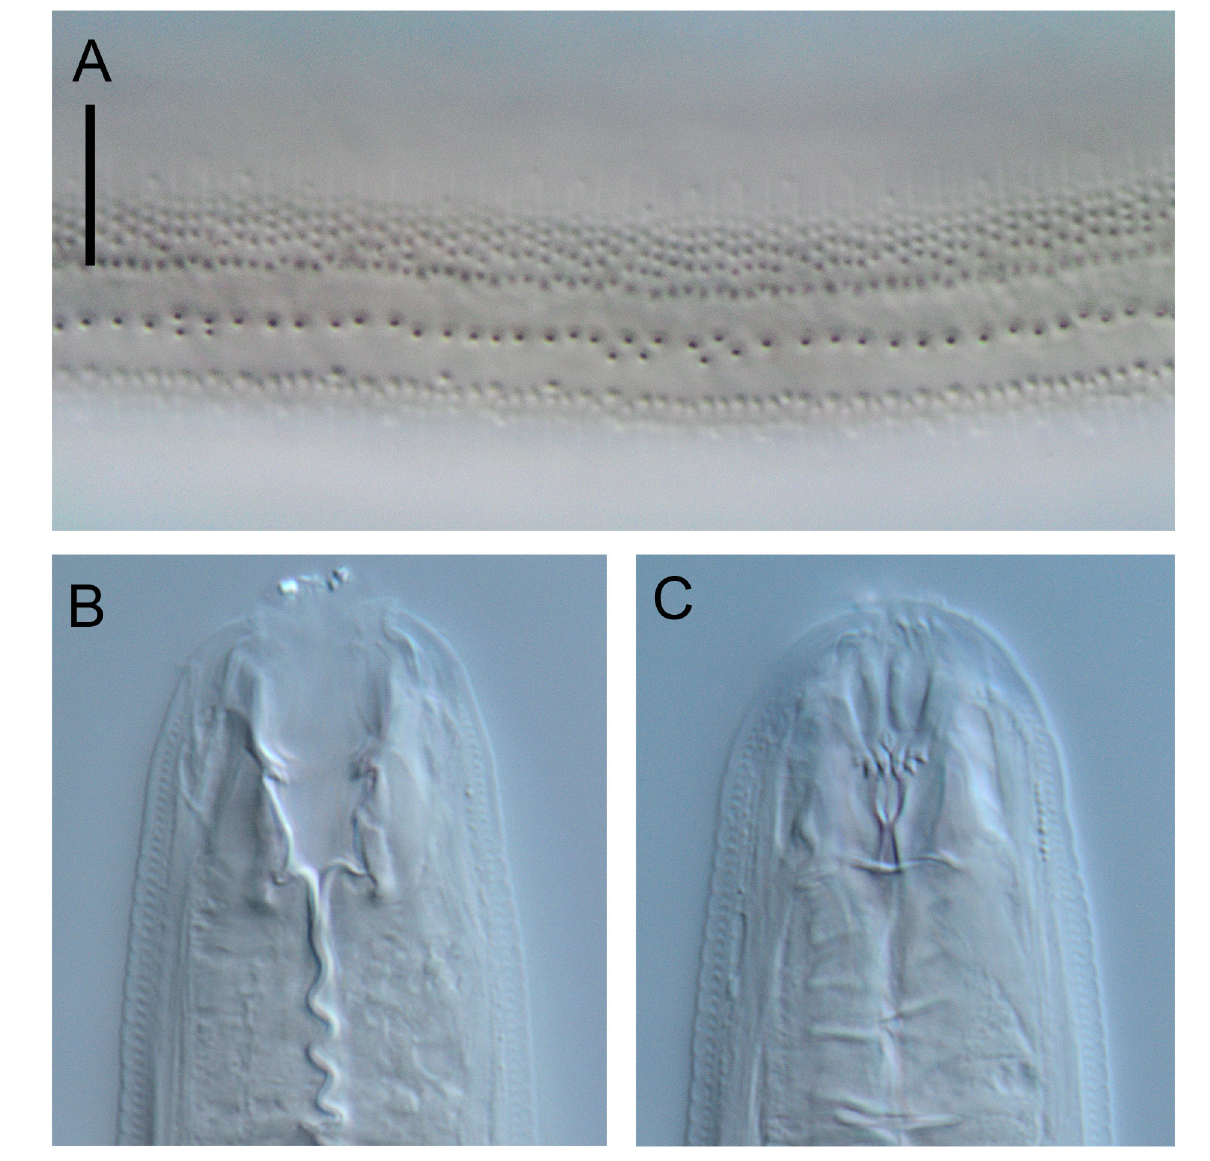
Fig. 16. Bendiella thalassa gen. et sp. nov. Light micrographs. A . Lateral view of male cuticle. B . Female head, showing shape of buccal cavity. C . Female head, showing details of rhabdions in anterior and posterior buccal cavity. Scale bar = 10